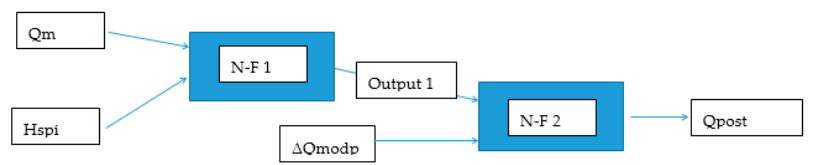
Figure 5. Schema of model NFM.